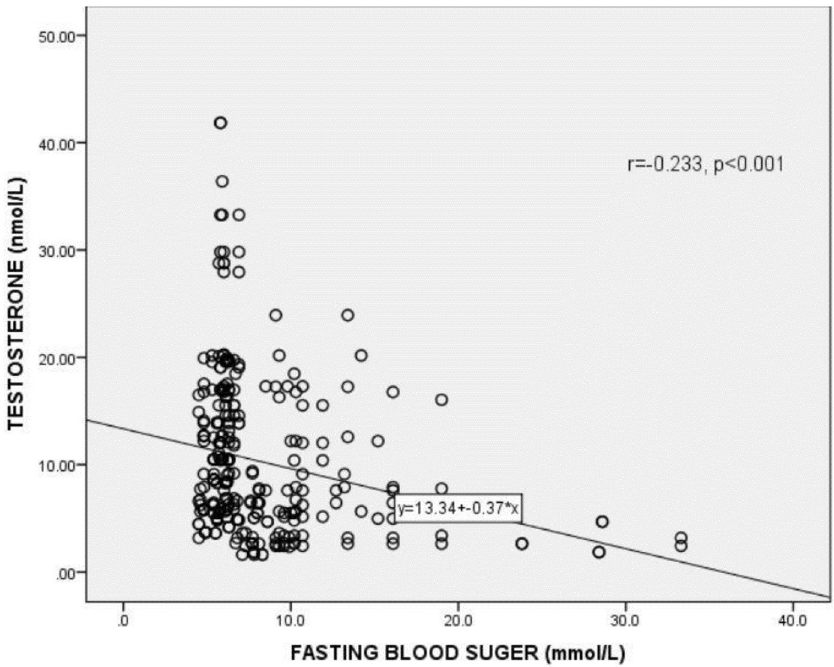
Fig 1. Correlation between testosterone levels and fasting blood glucose. r = Correlation coefficient. p < 0.05 was considered statistically